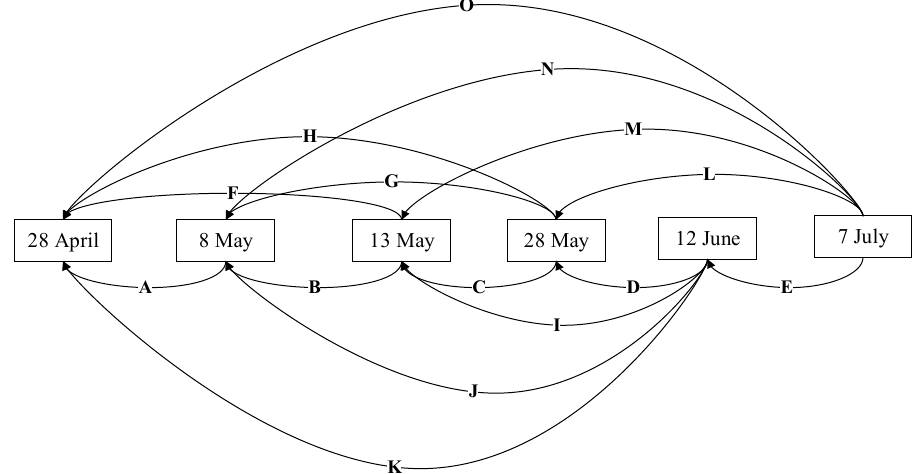
Figure 4. Diagram of the multi-temporal crop discrimination information in the 2020 crop early stage. Table 4. Definition of each letter in Figure 4 in 2020 different time phases.